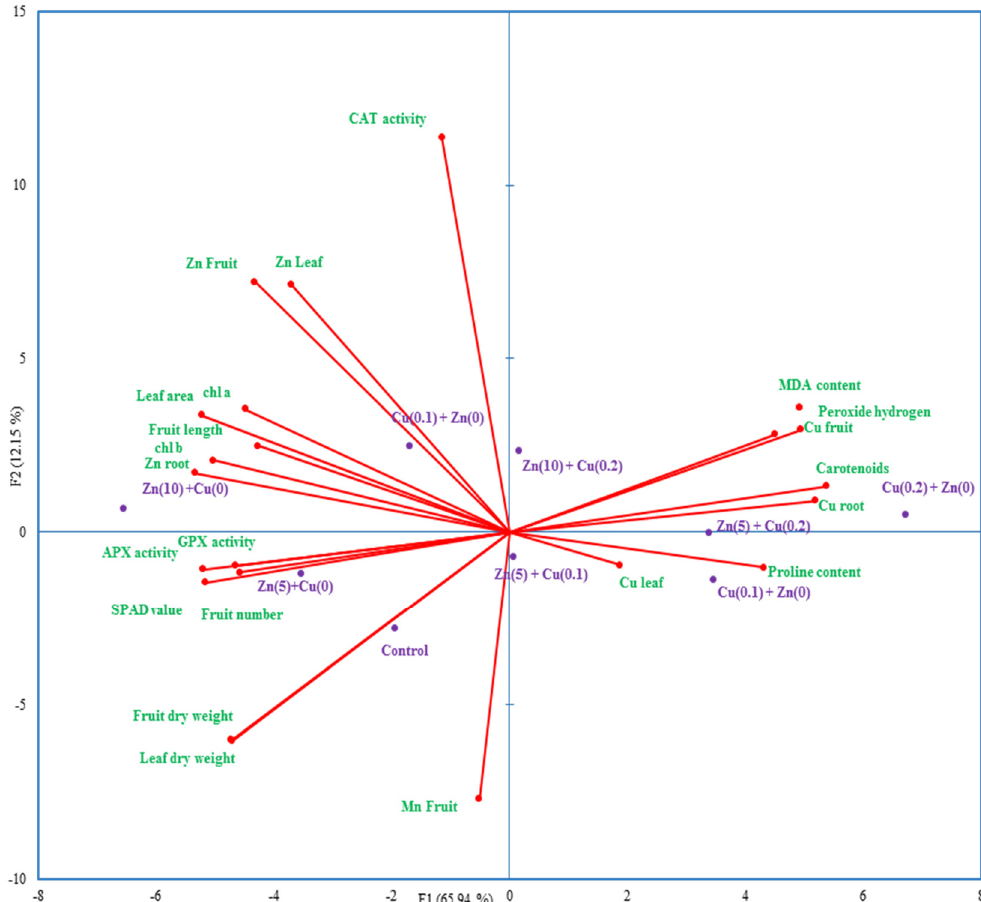
Figure 3. Principal component analysis (PCA) based on the correlation method unties the relationship between treatments and measured traits.